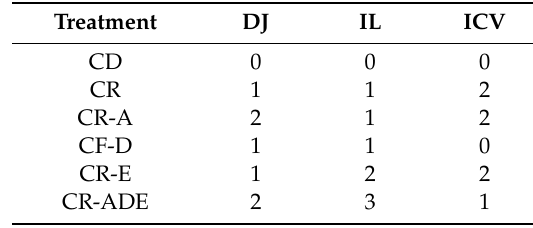
Table 2. Number of calves within treatment group that were culture positive for Mycobacterium avium subsp. paratuberculosis in select intestinal tissues 1